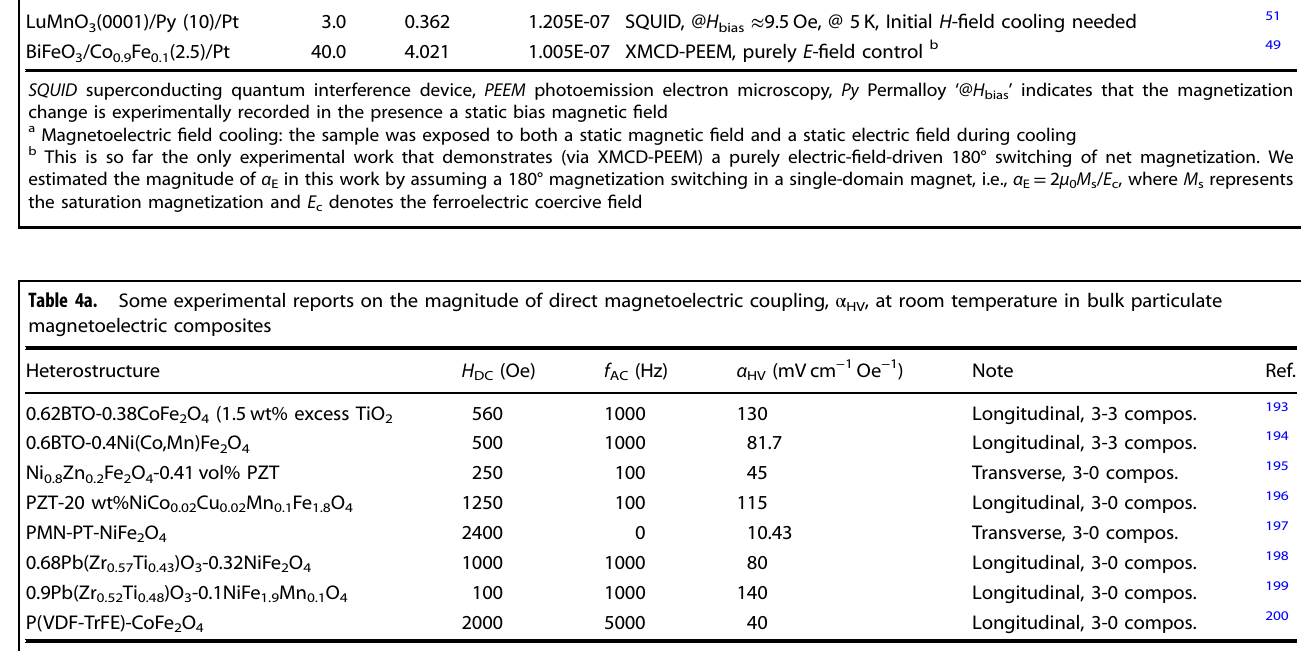
‘ Longitudinal ’ and ‘ transverse ’ indicate that the testing magnetic fi elds (including both the bias H DC and the driving H AC ) are applied parallel and perpendicular to the orientation of electric polarization, respectively. ‘ 3-3 ’ type connectivity of composites suggests a random mixture of grains of the two constituent phases; ‘ 3-0 ’ type connectivity indicate a (e.g., piezoelectric) matrix ( ‘ 3 ’ ) with embedded (e.g., magnetostrictive)